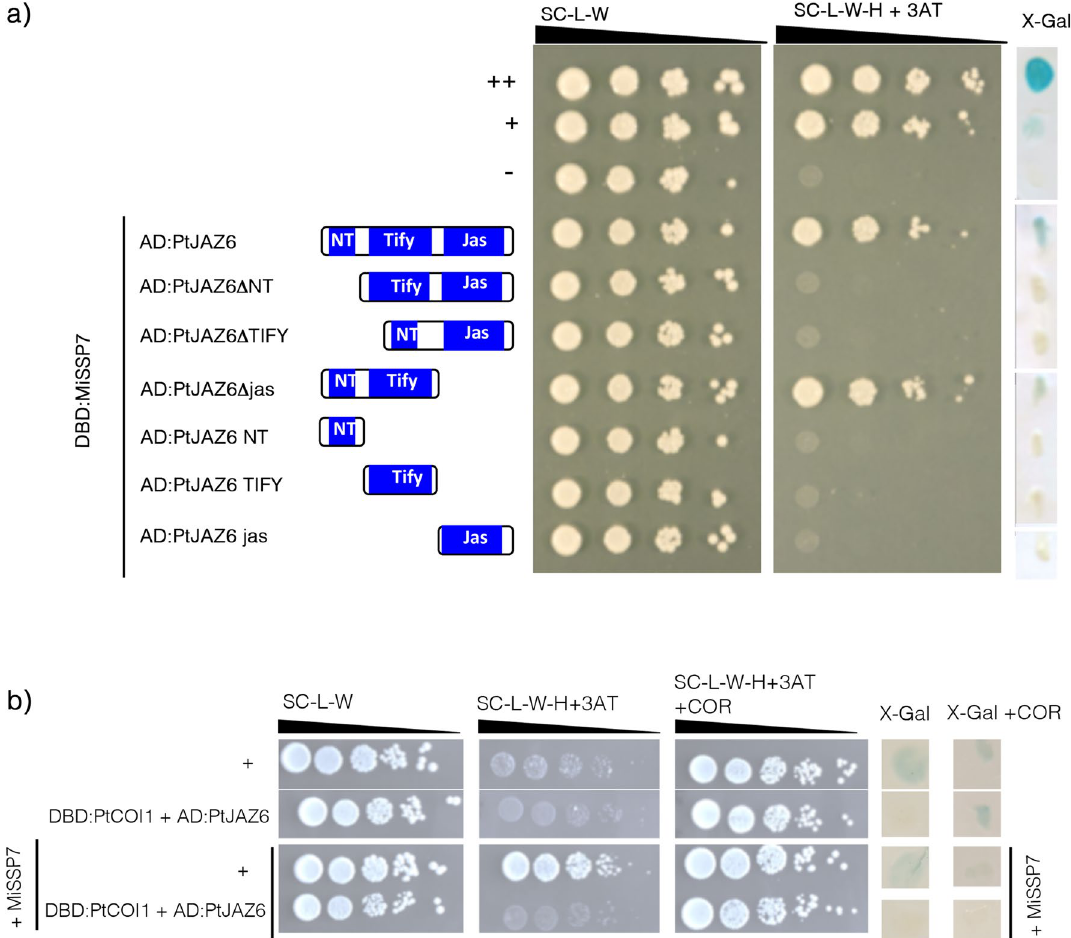
Figure 4. Both NT and TIFY domains of PtJAZ6 are necessary for its interaction with MiSSP7. ( a ) Yeast-two hybrid (Y2H) assays to assess which domains of PtJAZ6 are required for its interaction with MiSSP7. MiSSP7 was fused to the GAL4 DBD, whereas full length or mutated versions of PtJAZ6 were fused with the GAL4 AD. ( b ) Yeast-three hybrid assay to assess if the presence of MiSSP7 impacts the interaction between PtJAZ6 and PtJAZ6-PtCOI1. PtJAZ6 was fused to the GAL4 AD and PtCOI1 was fused to GAL4 DBD. Coronatine (COR) triggers the interaction betwen PtJAZ6 and PtCOI1 12 . TRP1 , LEU2 and URA3 served as transformation markers (the latter in case of triple hybrids) for vectors whereas HIS3 and β-galactosidase LacZ (X-Gal) were used as reporter genes. 3-Amino-1, 2, 4-triazole (3-AT) was used to suppress self-activation of the HIS3 gene. The control colonies are shown in the upper part of the panel: ++ is a strong positive interaction, + is a weakly interacting pair,— is a negative control (no interaction). 3-Amino-1, 2, 4-triazole (3-AT) was used to suppress self-activation at the HIS3 gene. White lines indicate cropped and repositioned images while the full-length blots and gels are presented in Supplementary Information